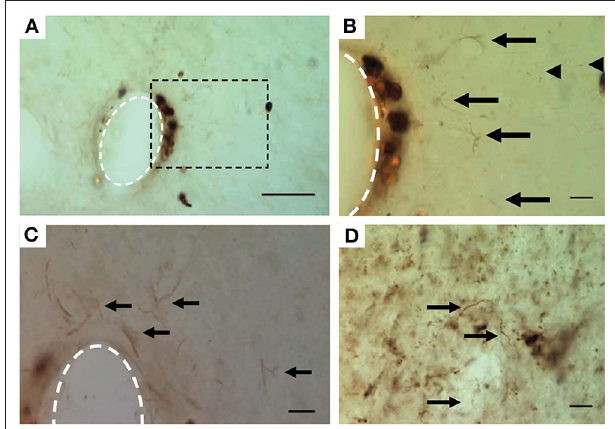
FIGURE 6 | Hyperphosphorylated tau surrounding chronically implanted microelectrodes 16 weeks post-implant. (A–C) Representative images of pT231 immunostained pretangles. (B) Boxed region in (A) at higher magnification. Note the increased presence of pT231 staining near non-specifically stained hemosiderin-laden macrophages. (C) Additional example from another implant showing the pT231 positive signal surrounding the electrode. Arrows indicate labeled diffuse granular pretangles and arrow heads indicate rodlike dystrophic neurites. (D) Positive control—human Alzheimer’s case sections contained stained processes similar to those seen around electrodes. The scale bar is 50 µ m (A) and 10 µ m (B–D) . Figure and caption reprinted with permission from McConnell et al. (2009b). © IOP Publishing. All rights reserved. Tau protein misfolding and